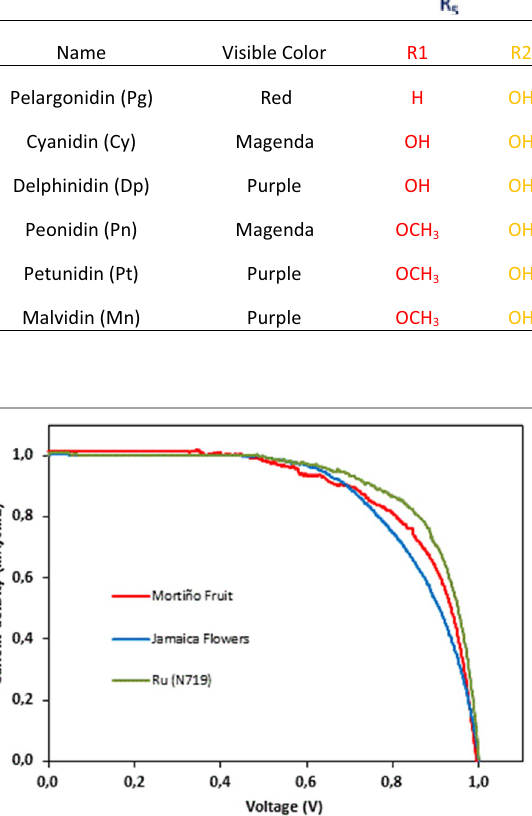
Fig. 7 Current–voltage curves for the DSSCs sensitized with extracts of a Jamaica flowers and b Mortiño fruit and c N719